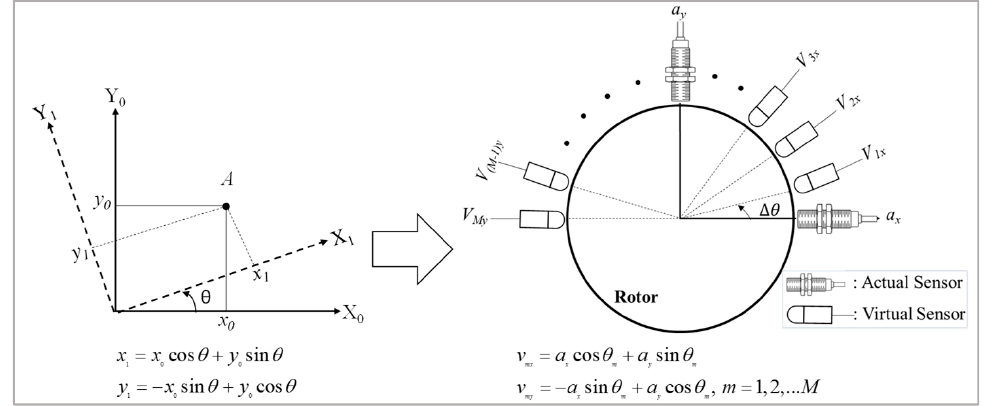
Figure 15. Concept of virtual sensors based on simple transformation of